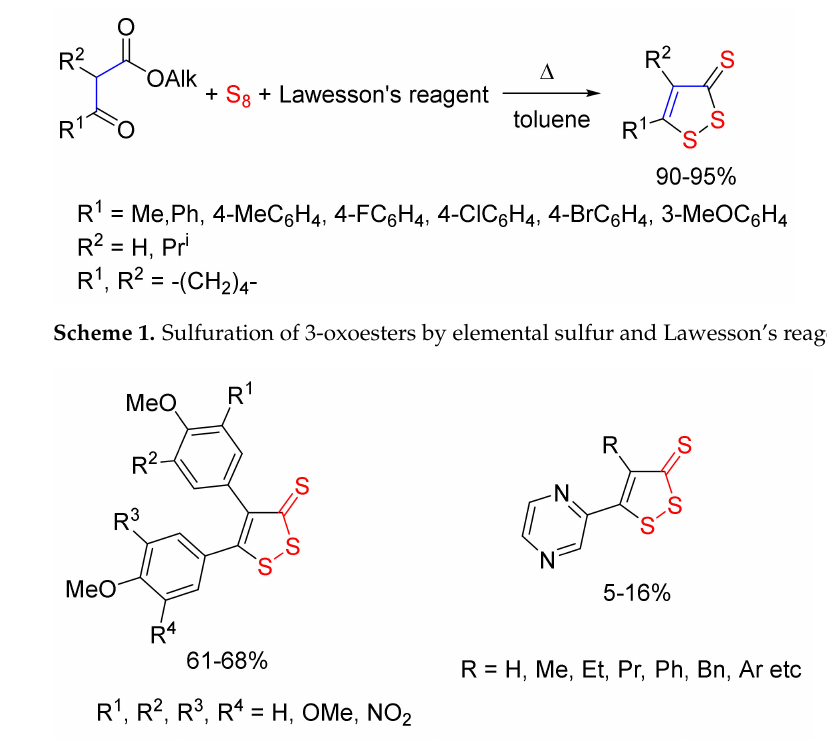
Figure 2. 3 H -1,2-Dithiole-3-thiones obtained by the reaction of 3-oxoesters and P 4 S 10